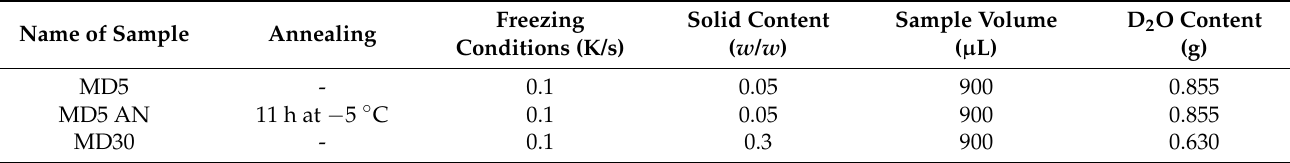
Table 1. Sample preparation and preprocessing parameters.